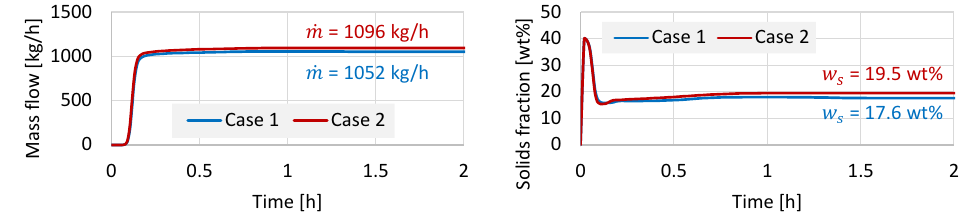
Figure 16. Time-dependent change in mass flow ( left ) and solids mass fraction ( right ) in the outlet stream of Centrifuge 2 (Concentrate 2 stream in Figure1) for each case